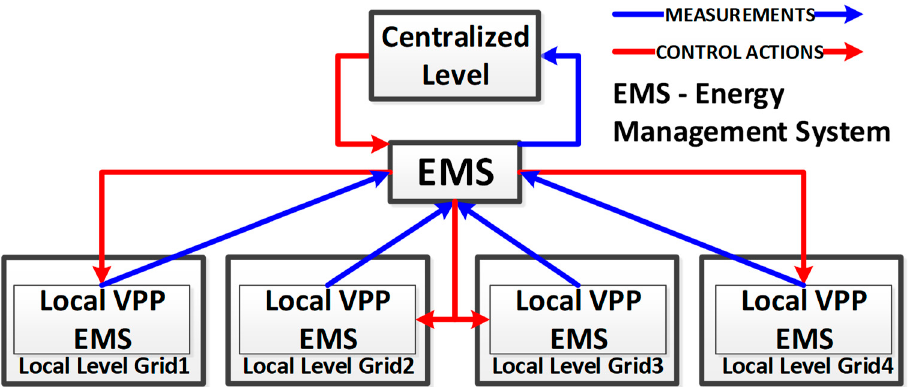
Figure 2. Two ‐ level operational management system. Figure 2. Two-level operational management